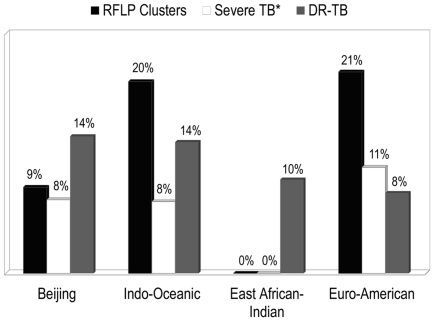
Proportion of recent tuberculosis transmission, severe disease, and drug resistant tuberculosis among derivation cohort patients.A comparison between patients within each MTB lineage group. Recent TB transmission is indicated by RFLP clusters. Abbreviations: RFLP = restriction fragment length polymorphism; DR-TB = drug resistant tuberculosis. *Severe TB indicates disseminated TB, TB meningitis, extensive bilateral lung consolidation or death during the course of TB therapy.